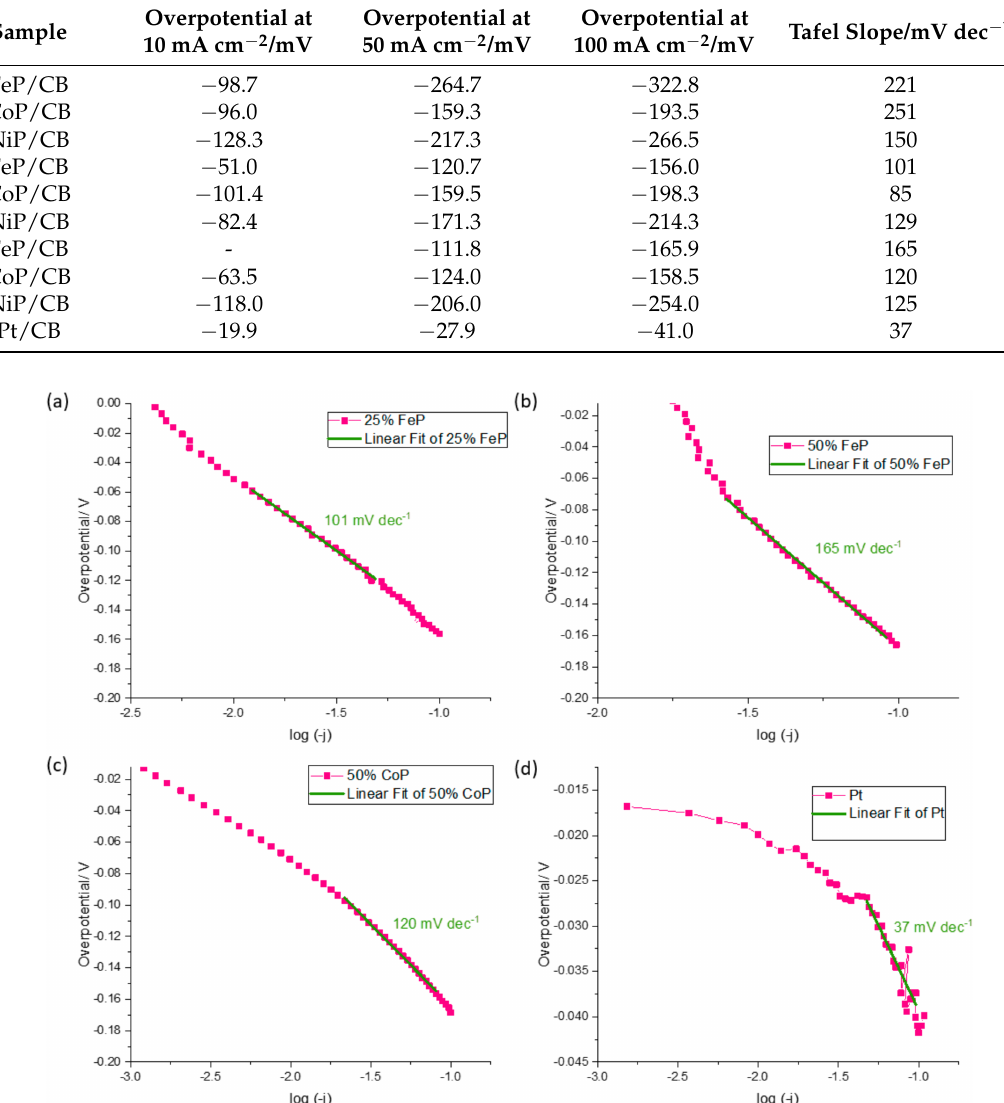
Table 4. Key catalytic parameters.